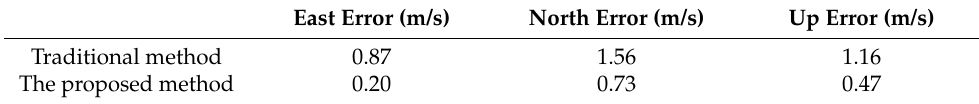
Table 2. Root Mean Square of velocity error under vehicle stationary condition.